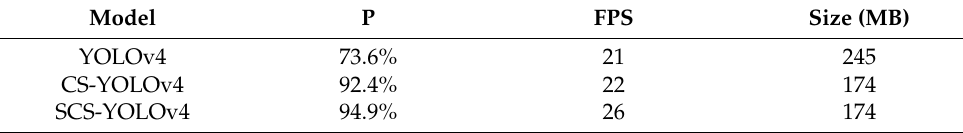
Table 3. Comparison of model performance after optimization (three-segment code).